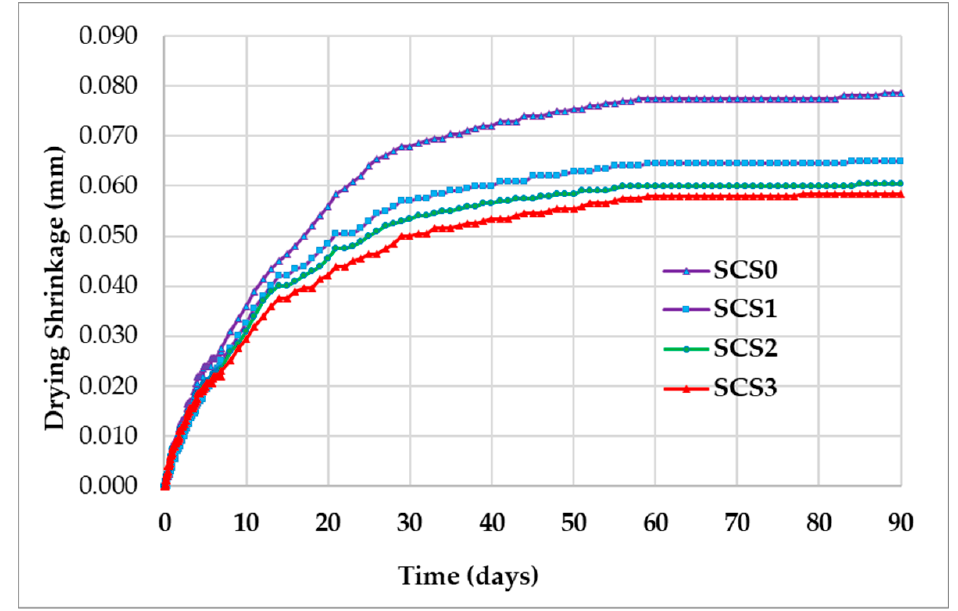
Figure 5. Average of drying shrinkage versus age of concrete from the results in Figure 4.